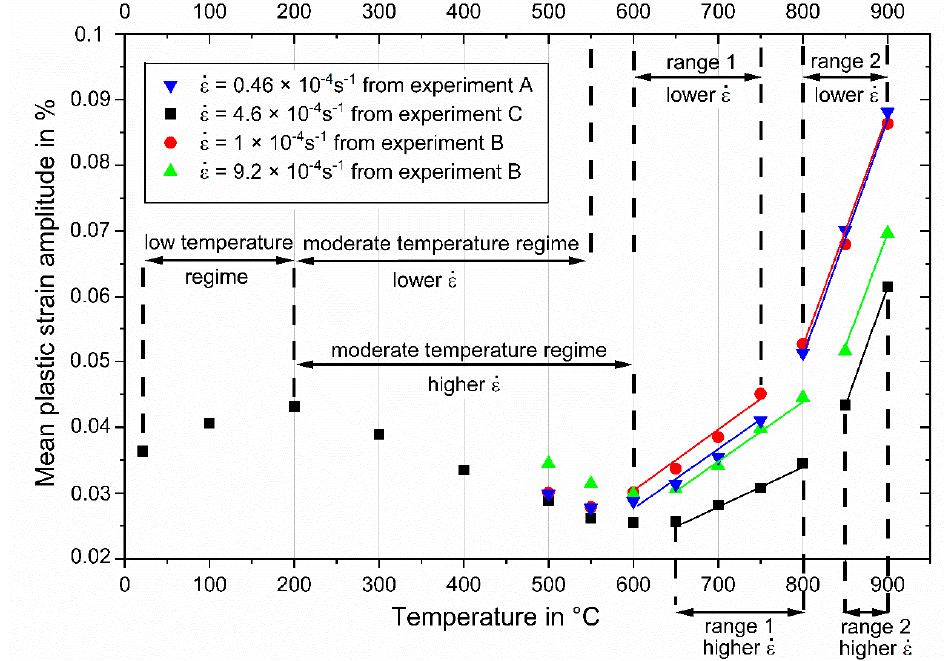
Figure 3. Relationship between the plastic strain amplitude from triangular cycles and the temperature at different strain rates.